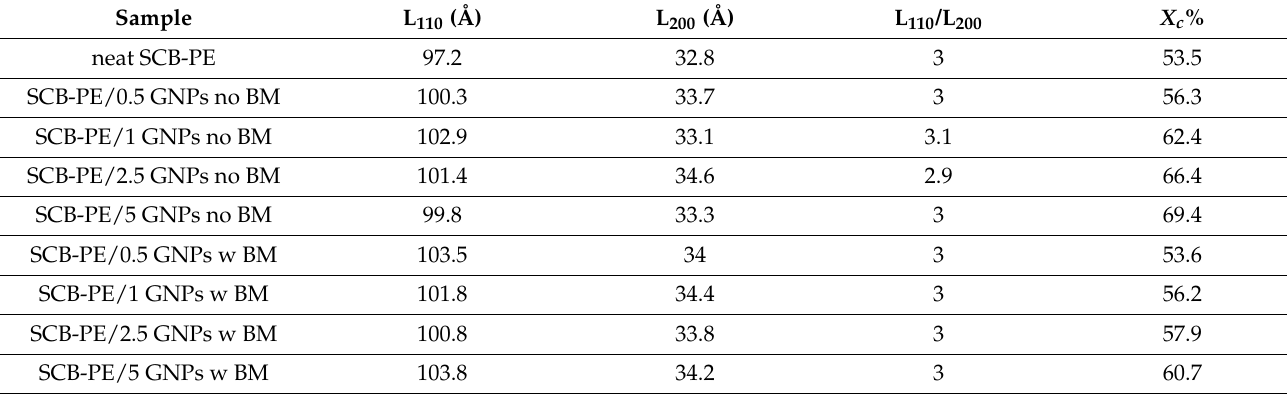
Table 1. Crystallinity degree values, lamellae thickness of (110) and (200) polyethylene’s crystalline planes and L110/L200 ratio of neat SCB-PE, SCB-PE/GNPs no BM and SCB-PE/GNPs w BM anocomposites.